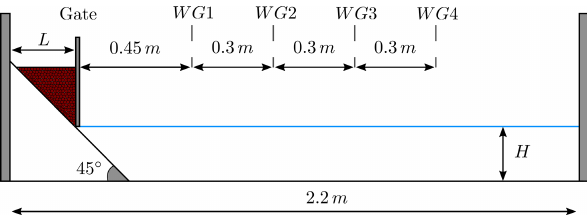
Figure 5. BP5 sketch of the setup for the laboratory experiments.